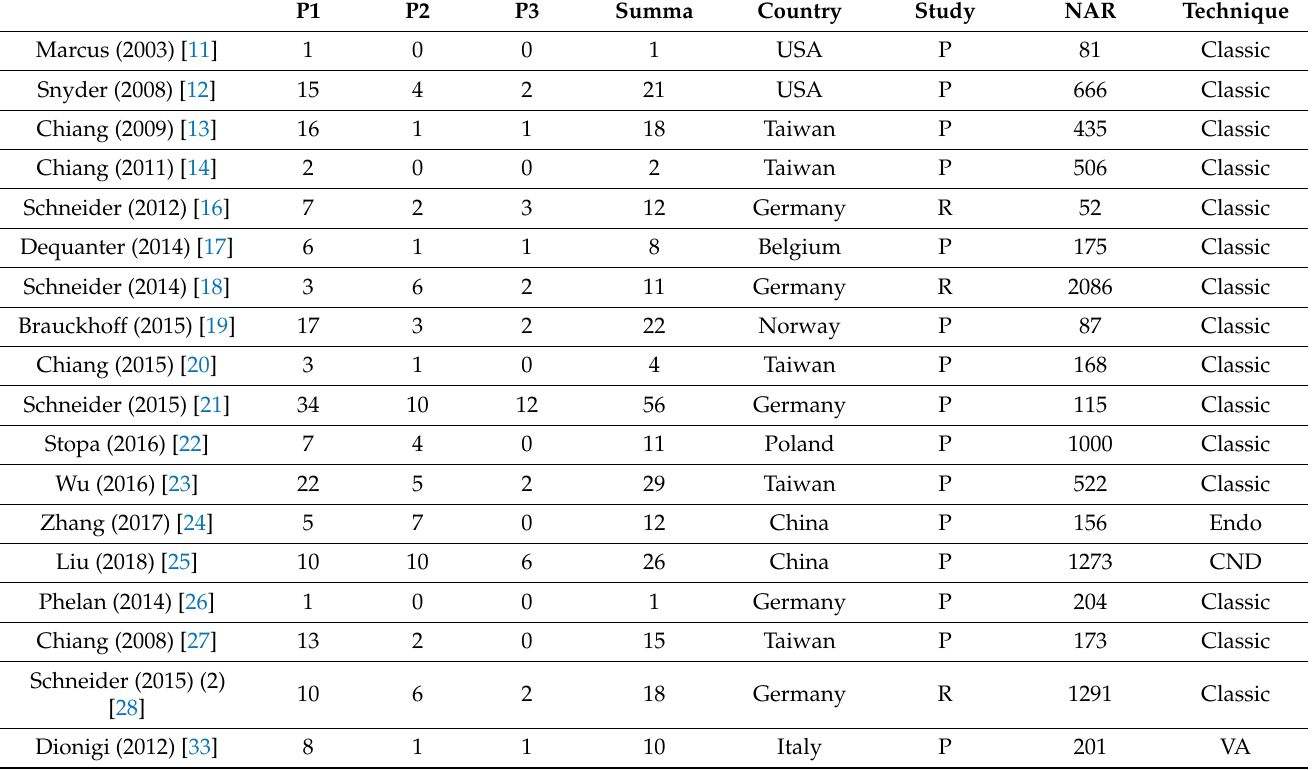
Table 1. Data of meta-analysis.